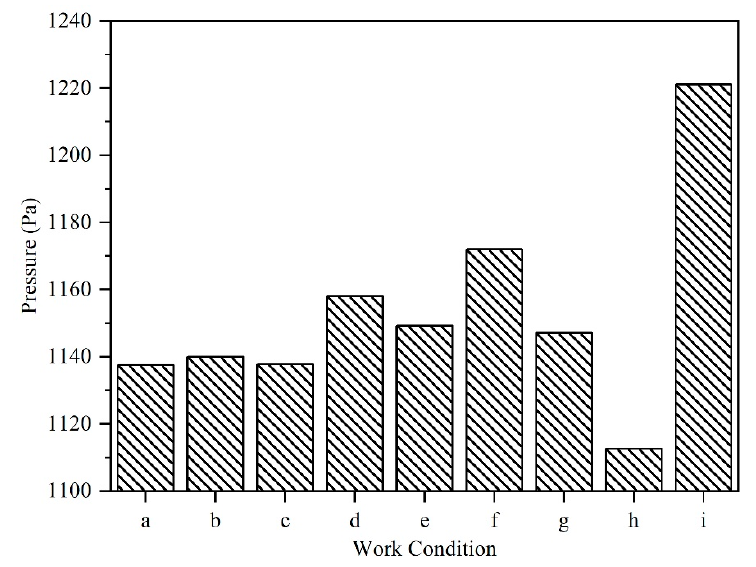
Figure 8. Average pressure on the first layer of eggs under different operating conditions (a–i).